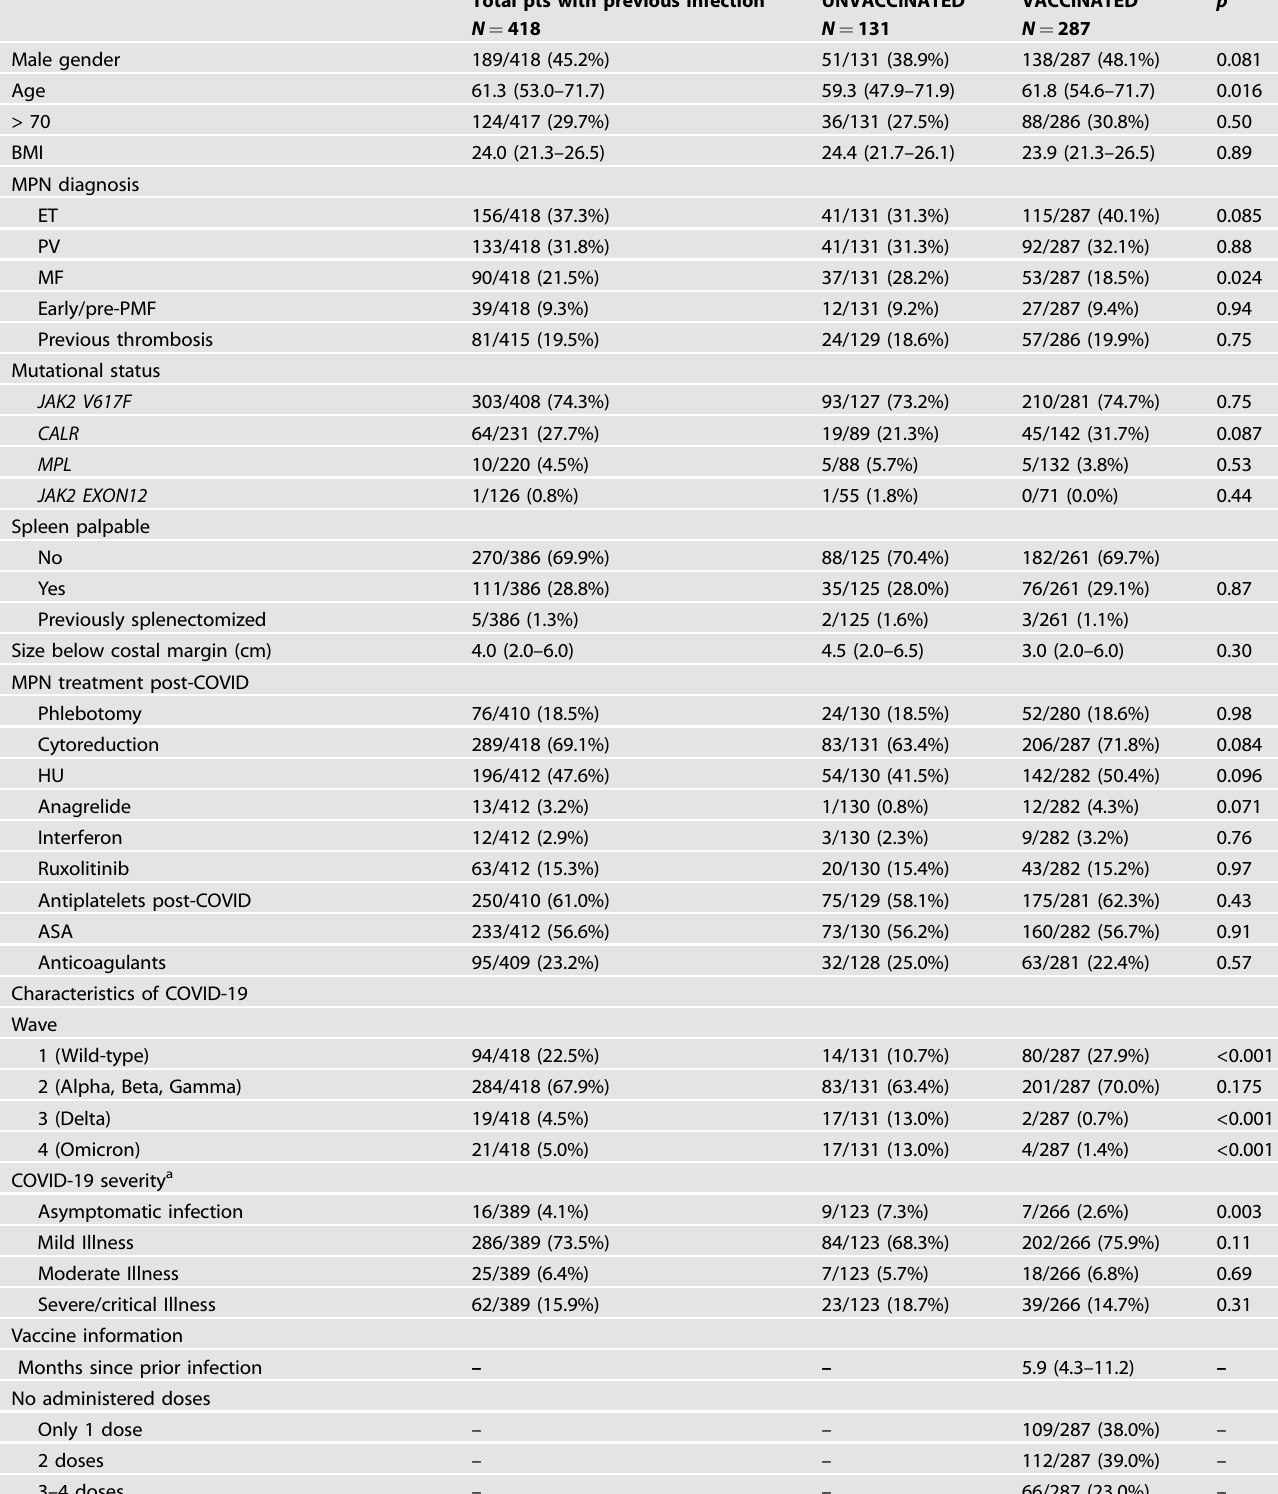
Table 1. Characteristics of patients with previous COVID-19 infection according to vaccination